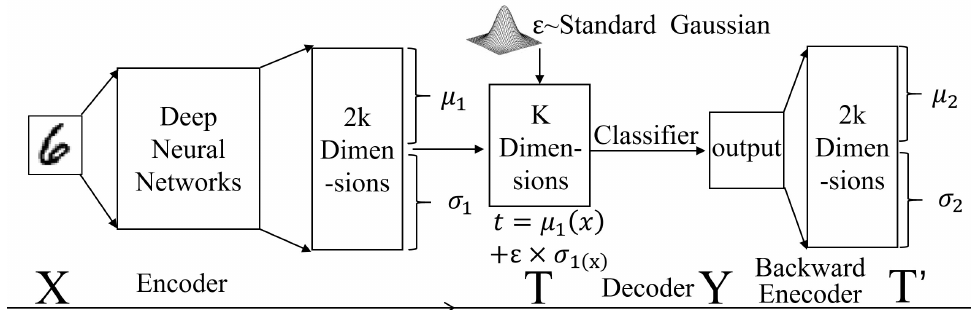
Figure A1. The network structure of variantional